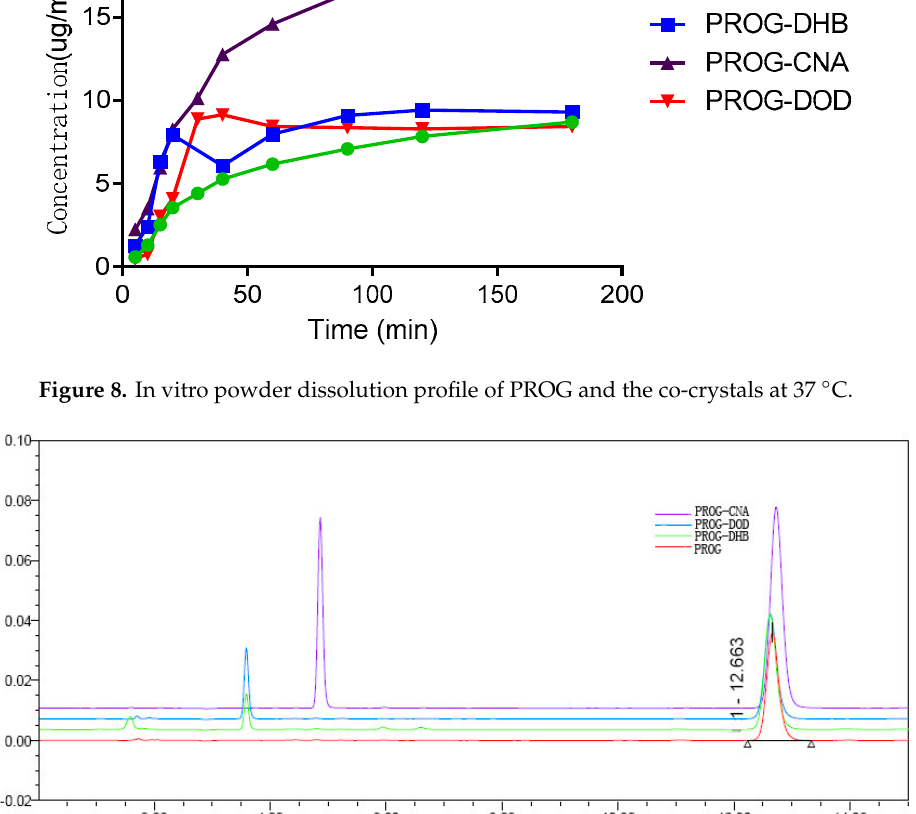
Figure 9. HPLC chromatograms of PROG and PROG-CNA, PROG-DHB, and PROG-DOD after 180 min in the dissolution study.